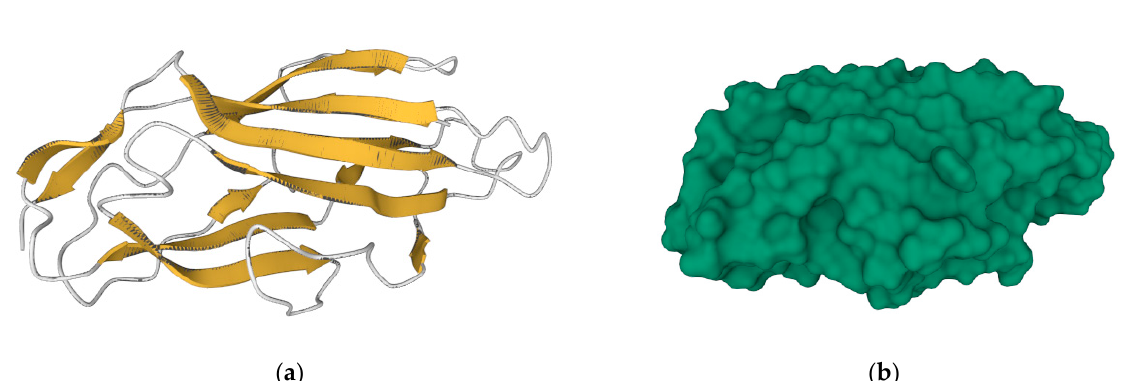
Figure 3. Secondary structures ( a ) and molecular surface ( b ) representation of FimH adhesin carbo- hydrate-binding domain from E. coli (https://www.rcsb.org/structure/3ZPD, accessed on 14 Decem- ber 2022). Bacterial attachment involves the molecular recognition between the FimH protein sur- face and the mammalian cell receptor, and thus the prophylactic vaccination with FimH adhesin can impede bacterial colonization, block infection, and consequently, prevent disease.